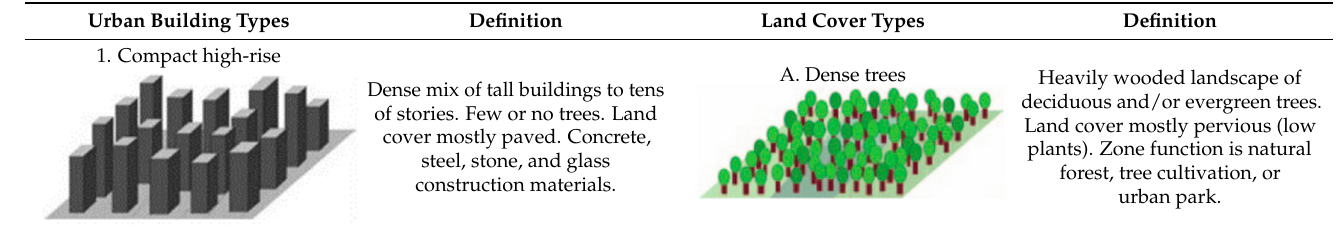
Table A1. Specific descriptive information for each type of LCZs [13] American Meteorological So-